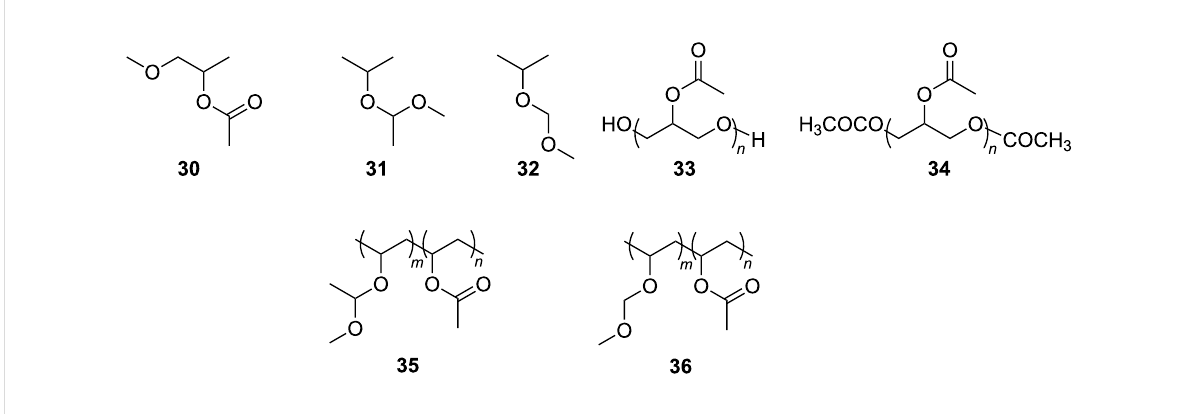
Figure 4: Structures of three CO 2 -philic candidates: ( 30 ) MIA, ( 31 ) 2MEP and ( 32 ) 2MMP and the respective polymer candidates they produce: ( 33 ) -OH terminated oligo(3-acetoxy acetate), OAO, based on MIA; ( 34 ) -OCOCH 3 terminated OAO, also based on MIA; ( 35 ) PVMEE,